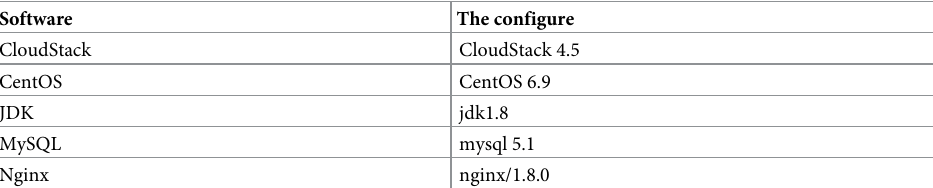
Table 4. Experiment environment.